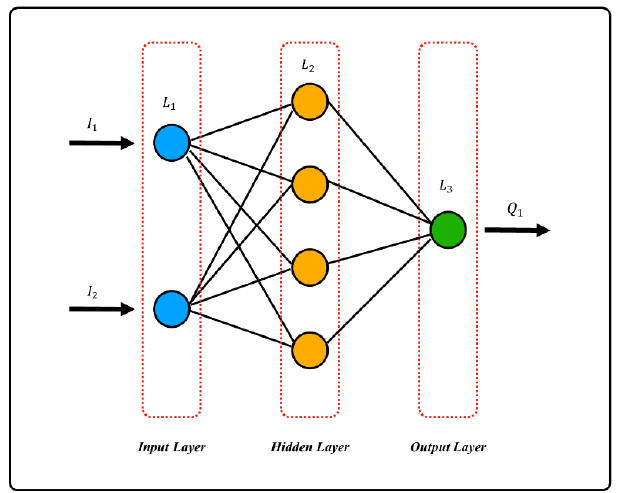
Figure 1. Illustration of basic NN architecture.